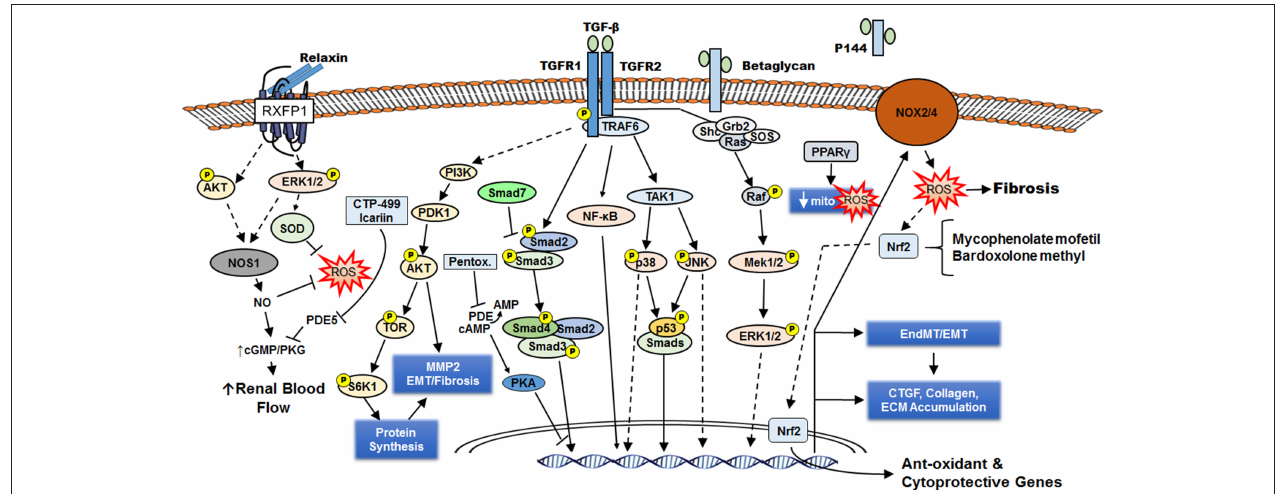
FIGURE 1 | Renal fibrosis occurs downstream of TGF- β intracellular signaling and increased ROS generation. Through its cell surface receptors TGFR1 and TGFR2, TGF- β activates several signaling cascades (including AKT, Smad2/3, NF- κ B, p38 MAPK, JNK, ERK1/2) that lead to formation of activated fibroblasts (directly from interstitial fibroblasts or by epithelial mesenchymal transition/EMT or endothelial to mesenchymal transition/EndMT). These myofibroblasts synthesize ECM components leading to fibrosis and express NOX2/4 that generates ROS, which can enhance fibrosis or induce anti-oxidant/cytoprotective genes by activating the transcription factor Nrf2. Activation of the nuclear receptor PPAR γ also reduces ROS formation by improving mitochondrial function and defenses. The cell-surface chondroitin sulfate/heparan sulfate proteoglycan betaglycan facilitates the interaction of TGF- β with TGFR2, and a soluble truncated form of betaglycan (P144) can serve as a decoy receptor to attenuate TGF- β signaling. The hormone relaxin engages the G-protein receptor RXFP1 to induce NOS1 expression and generate NO, which can directly reduce ROS or indirectly reduce ROS via increased renal blood flow. The PDE5 inhibitors CTP-499 and Icariin enhance the beneficial effects of NO on the kidney. By increasing cAMP and PKA activity, the PDE inhibitor pentoxifylline interferes with Smad3/4-dependent CTGF transcription. CTGF enhances TGF- β